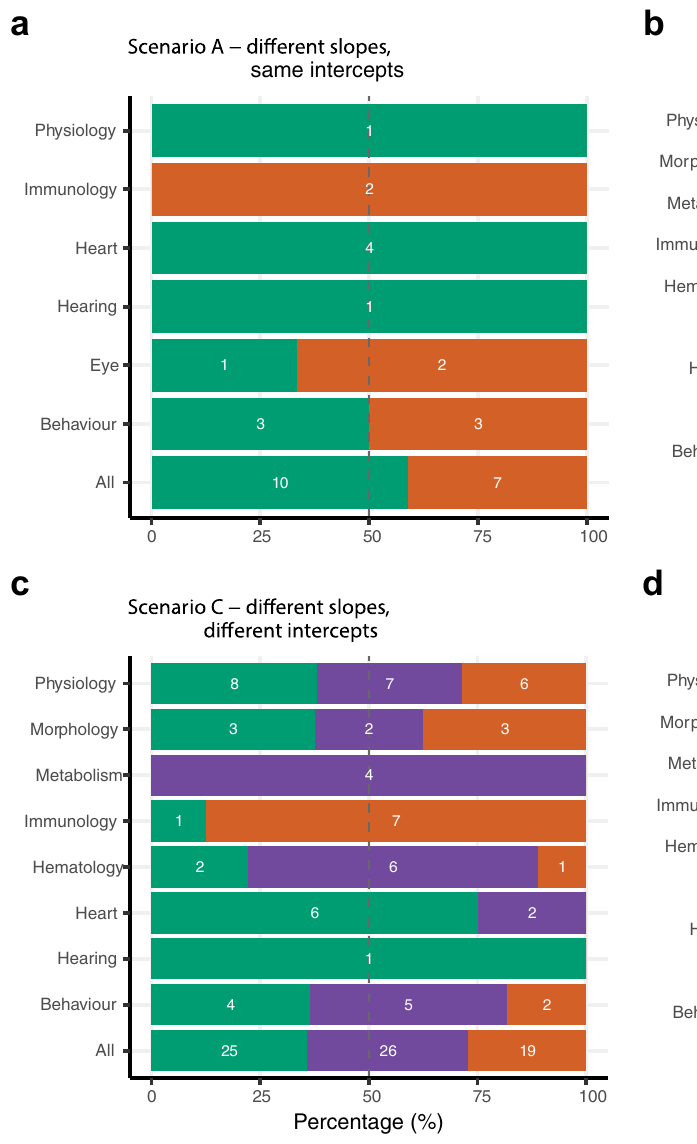
the orange bars represent the number of female biased traits, and those insidethe purple bars represent a combination of female bias (for intercept or slope) and male bias (for intercept or slope). a Differences between the sexes for slope. b Differences between the sexes for intercept. c Differences between the sexes for slopeandintercept,includingtraitswithmixed(purple)signi fi cantdifferences(i.e., male-biased signi fi cant slope and female-biased signi fi cant intercept, or female- biasedsigni fi cantslopeandmale-biasedsigni fi cantintercept). d Biasinstatistically signi fi cant difference in variance (residual SD) between the